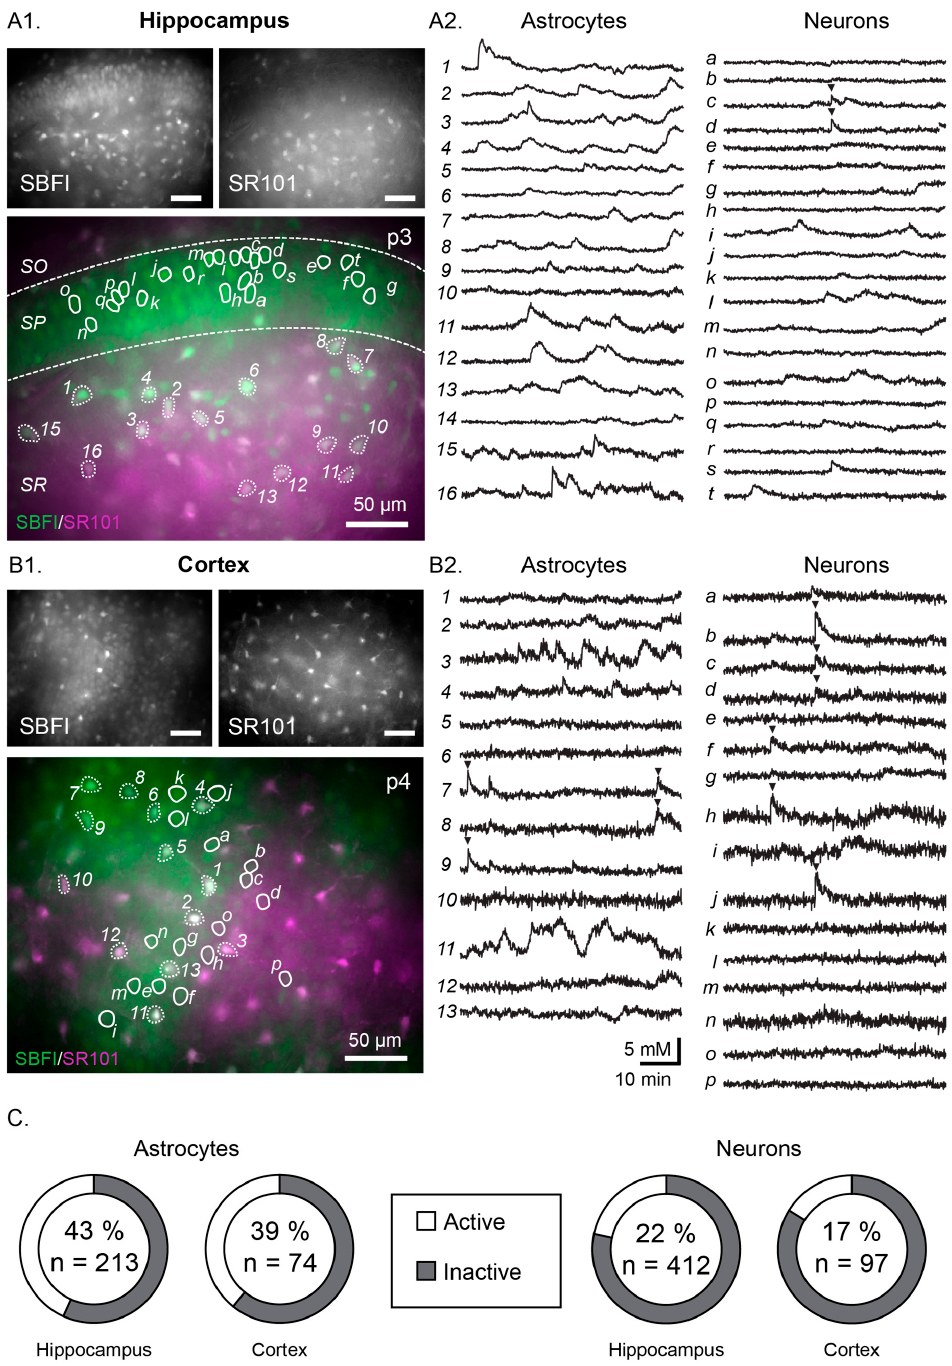
Figure 1. Example measurements showing spontaneous Na + fluctuations in the neonate hippocampus ( A1 , A2 ) and neocortex ( B1 , B2 ). ( A1 , B1 ) show the SBFI (top left), SR101 (top right) and merge images (bottom) with all scale bars indicating 50 µm. Circled areas correspond to regions of interest (ROIs), the individual fluorescent measurement traces of which are illustrated in ( A2 , B2 ) (astrocytes on the left and numbered, neurons on the right and labelled with letters). Arrows indicate instances when the cells appear to be synchronized. ( C ) Pie charts indicating the percentage of active astrocytes (left) and neurons (right) within each area ( n = total number of cells measured). SBFI: sodium-binding benzofuran isophthalate-acetoxymethyl ester. Table 2 should be replaced with the